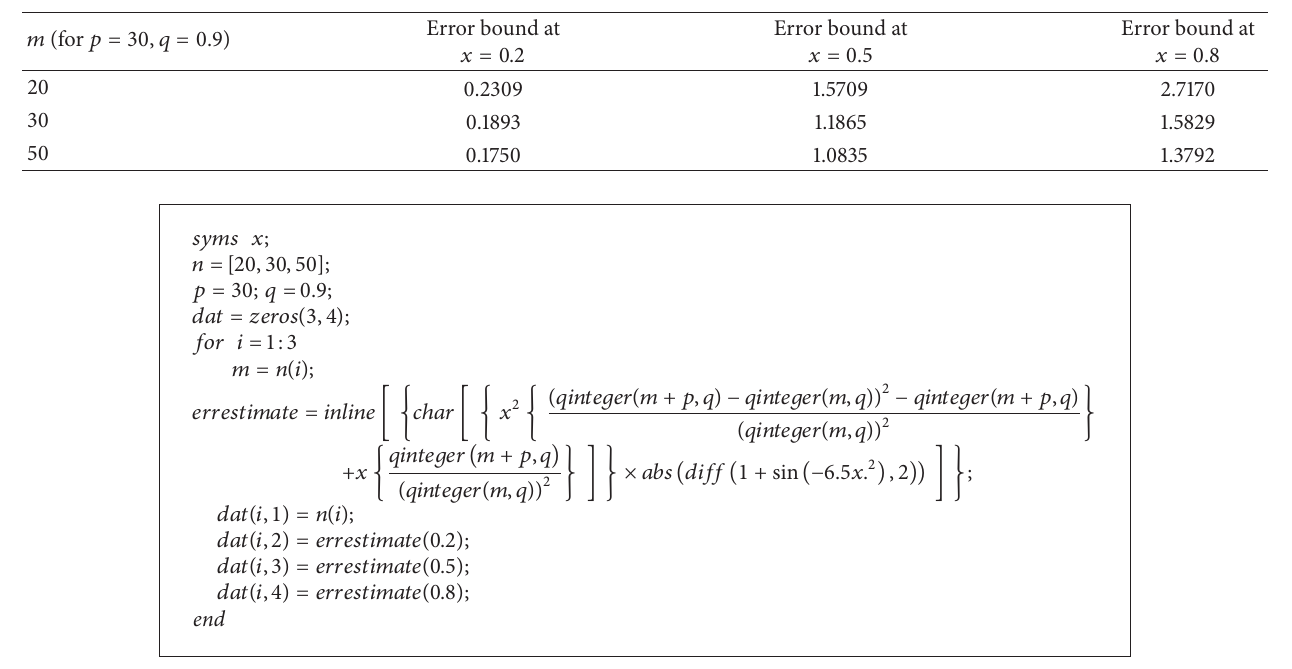
Table 1: Error estimation table.